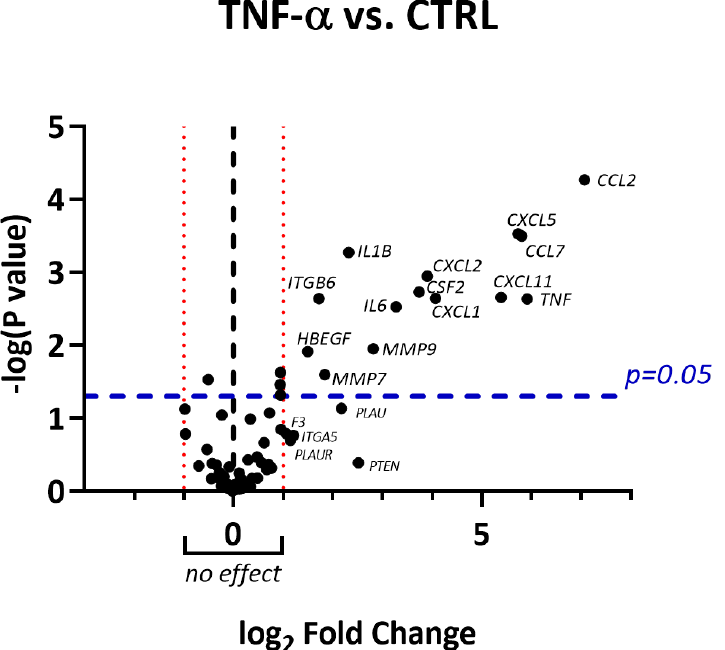
Figure 2. Volcano plot showing the entity of gene up/downregulation induced by TNF-α (10 ng/mL, 6 h) together with statistical significance. Only genes with absolute fold change greater than 2 (log 2 fold change greater than 1) and p < 0.05 were considered significantly regulated.